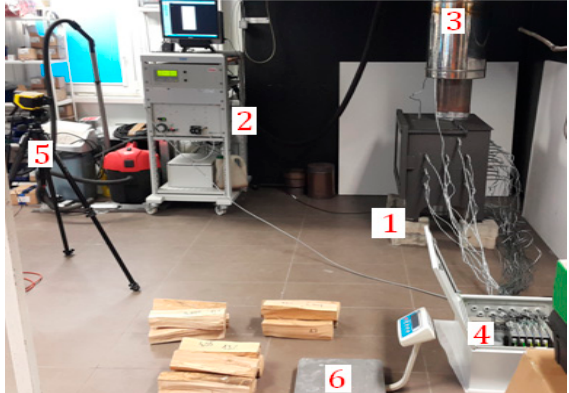
Figure 2. The facility of the testing bench: 1 fireplace insert with thermocouples, 2, 4 data acquisition units, 3 a vertical smoke conduit with mounted measuring section, 5 thermal camera, 6 electronic scale.